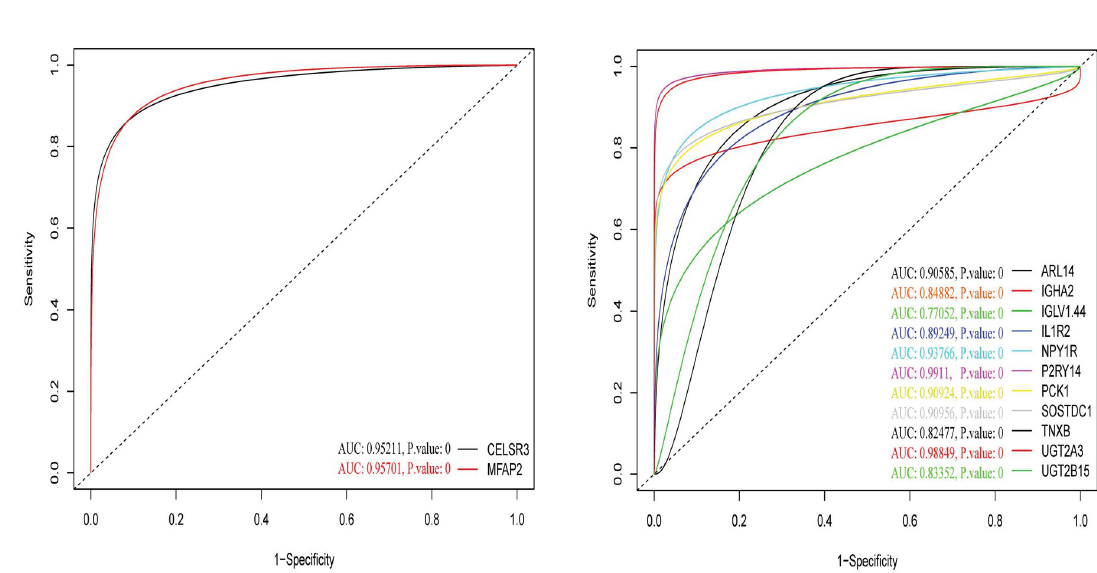
Fig 23. ROC curves for novel validated Differentially Expressed Genes (vDEGs). Left curve) Over-expressed novel vDEGs. Right curve) Under-expressed novel vDEGs.